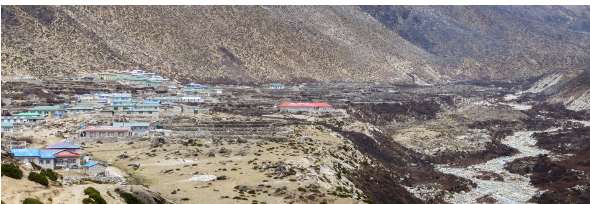
Figure 2. The village of Dingboche on the Imja Khola showing the river (right) and the relative height from the river course to the arable land and houses (about